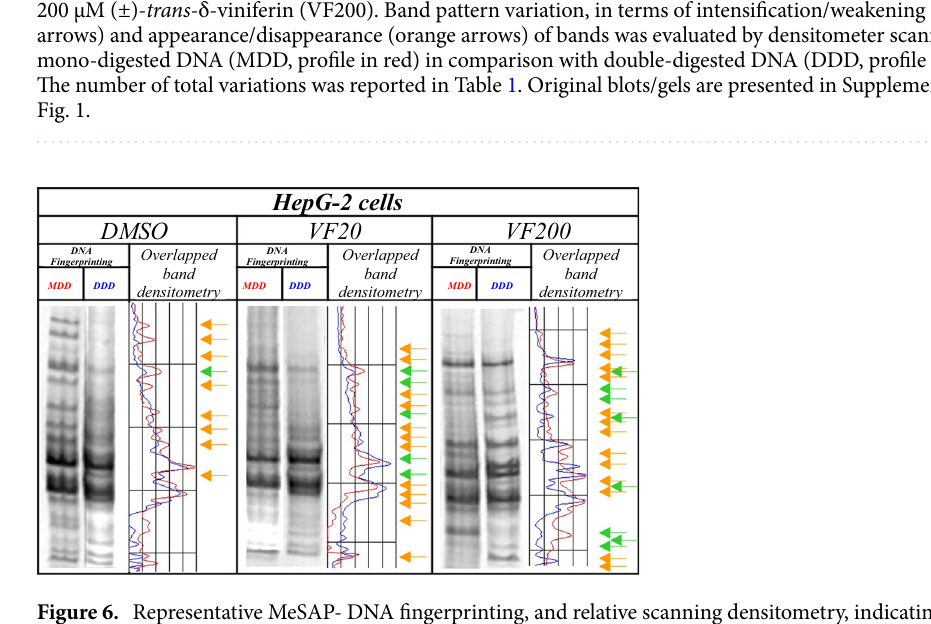
Figure 6. Representative MeSAP- DNA fingerprinting, and relative scanning densitometry, indicating genomic DNA methylation of HepG-2 cells treated with: (from left) DMSO–vehicle; 20 µM (±)- trans -δ-viniferin (VF20); 200 µM (±)- trans -δ-viniferin (VF200). Band pattern variation, in terms of intensification/weakening (green arrows) and appearance/disappearance (orange arrows) was evaluated by densitometer scanning of mono- digested DNA (MDD, profile in red) in comparison with double-digested DNA (DDD, profile in blue). The number of total variations was reported in Table 1. Original blots/gels are presented in Supplementary Fig. 1.